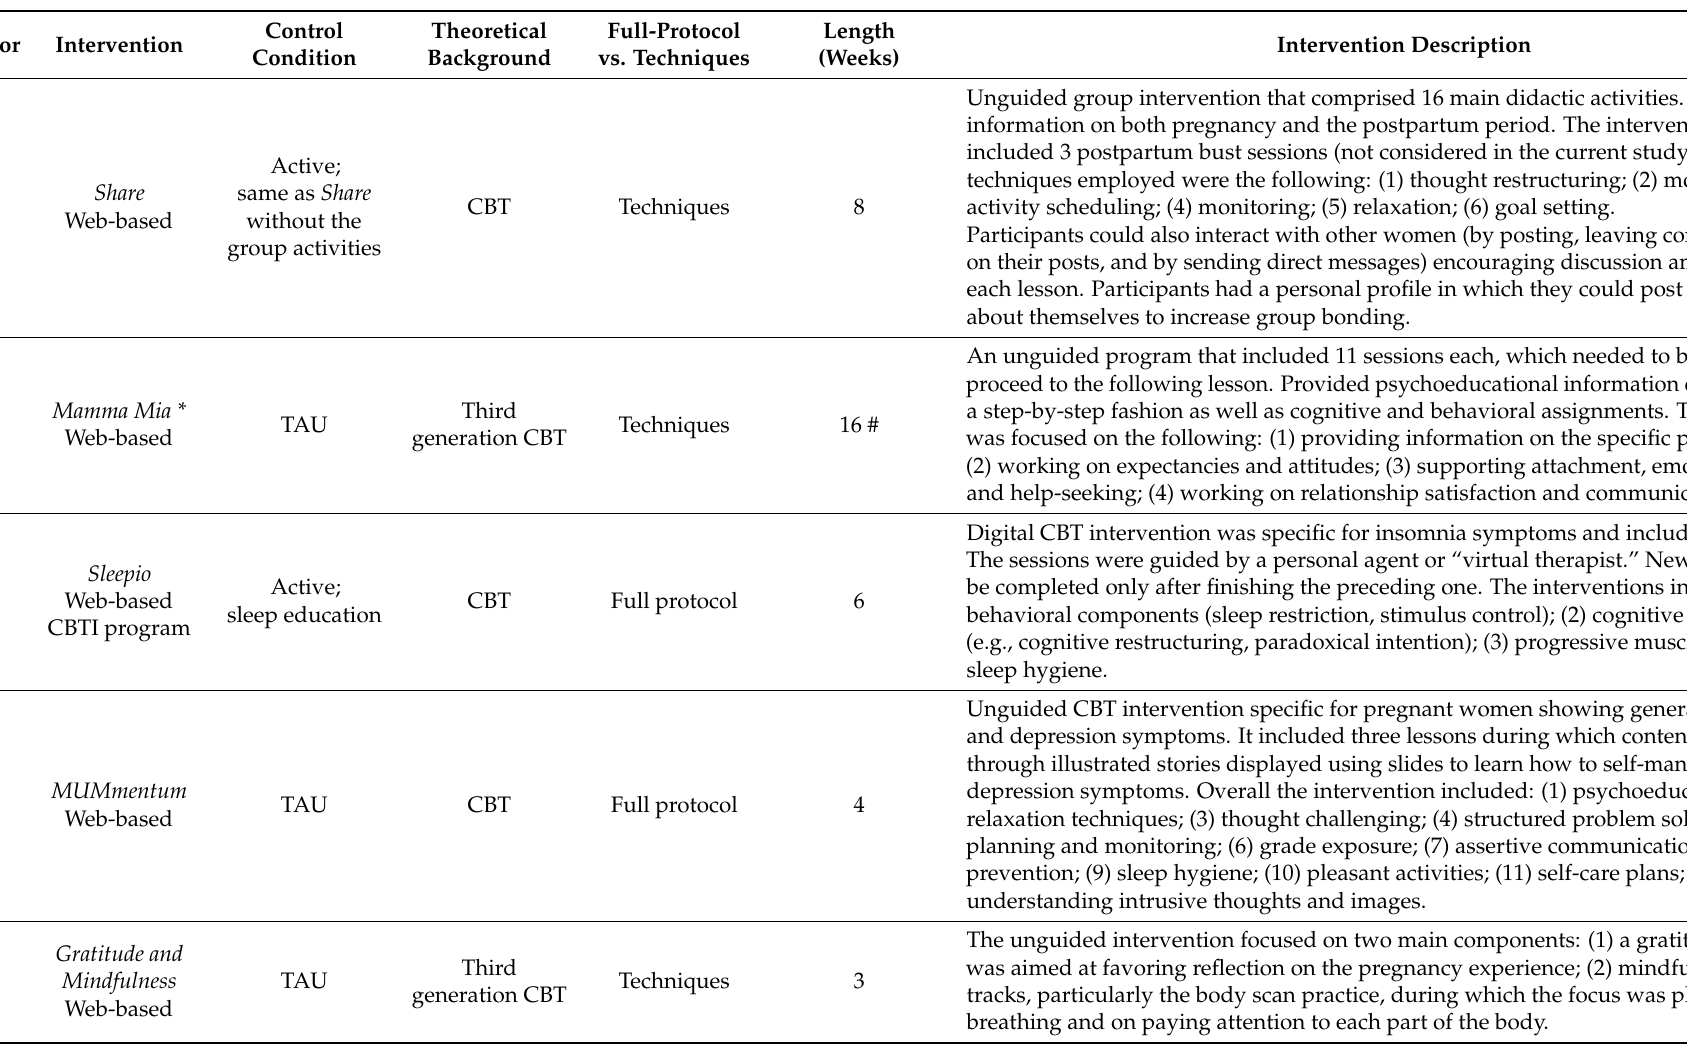
Table 2. Intervention